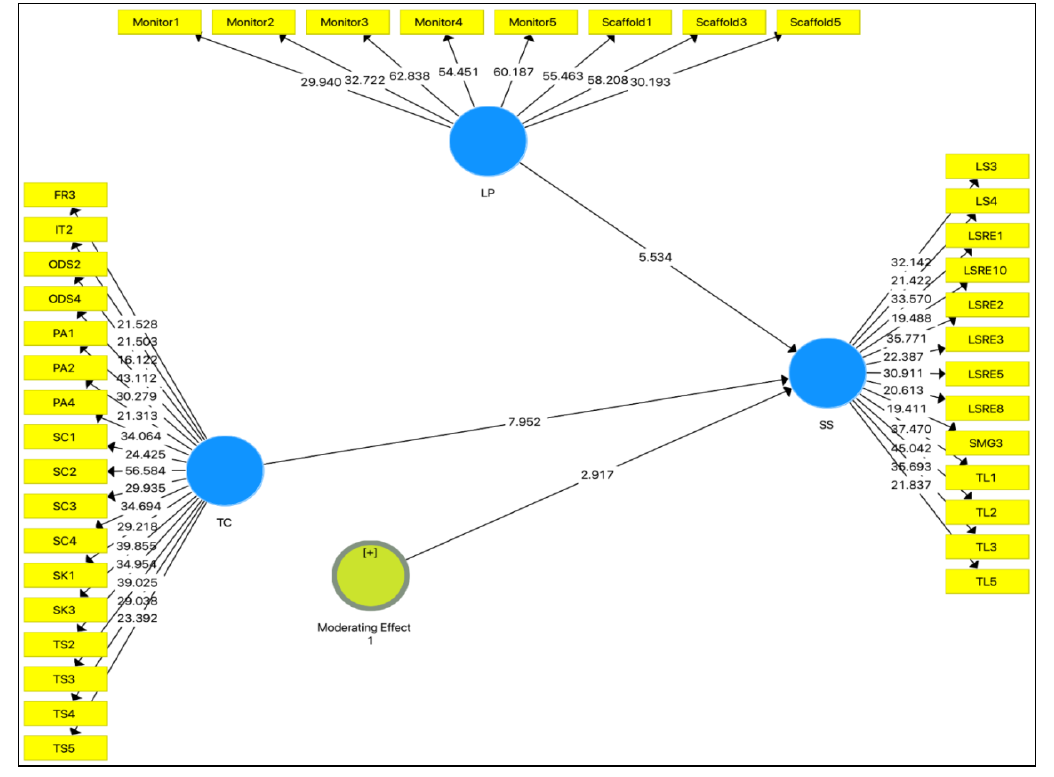
Figure.3. Structural Model (Bootstrapping)